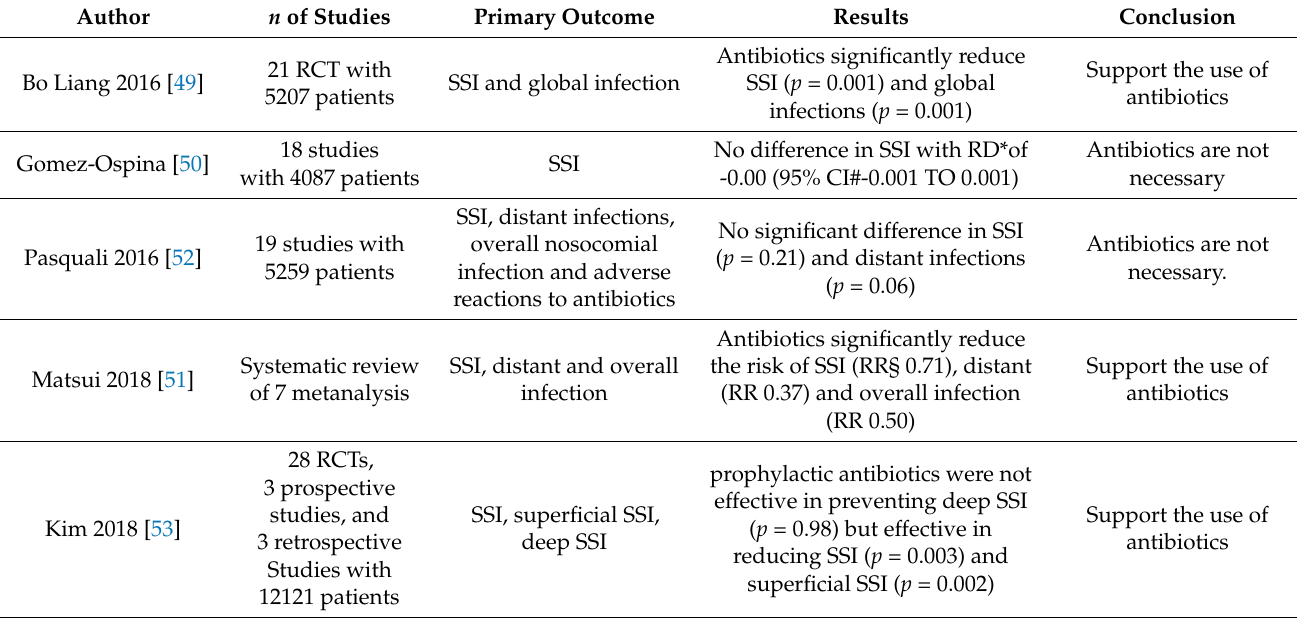
Table 2. Evidence obtained from the